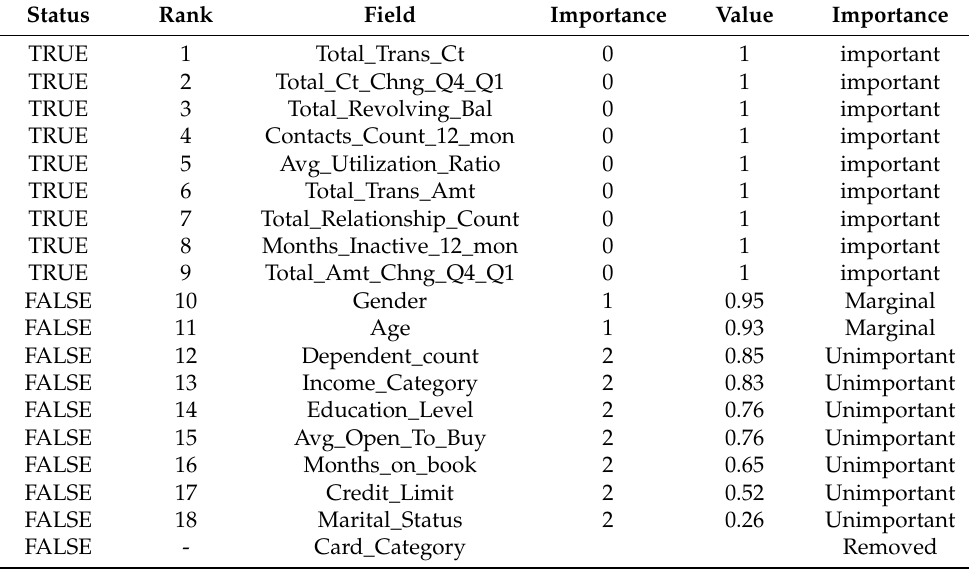
Table 4. The output of the feature-selection method.